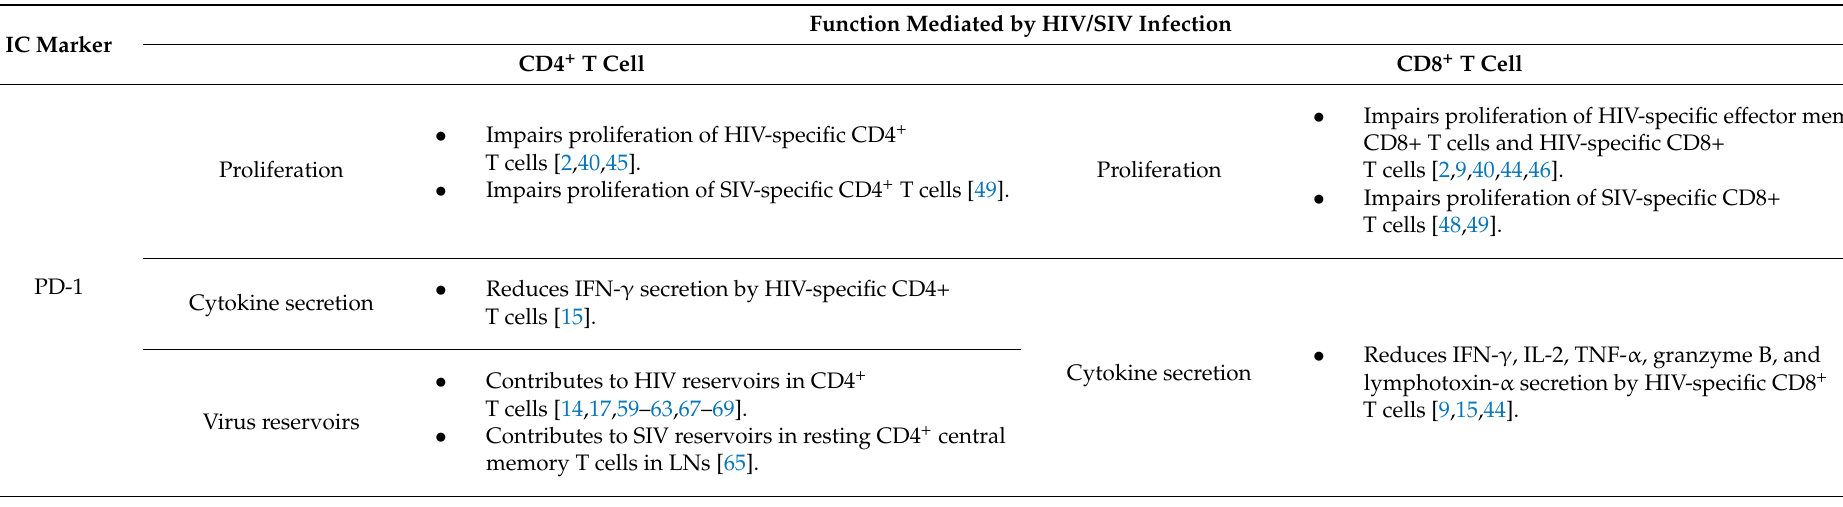
Table 2. Biological role of immune checkpoint markers on T cell function in HIV/SIV